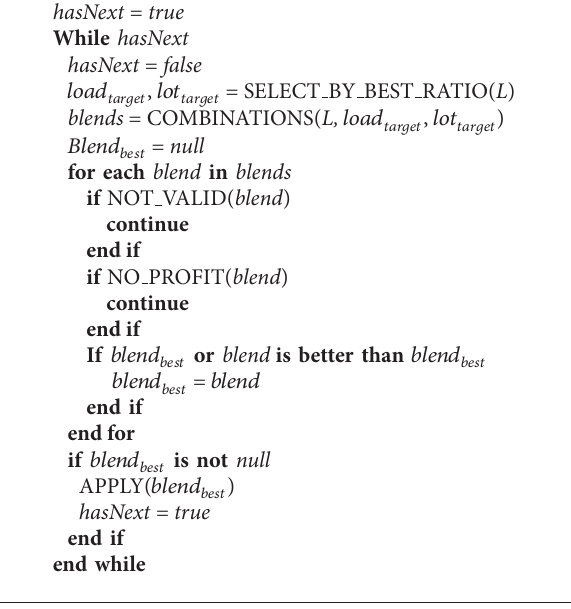
Algorithm 1: Heuristic